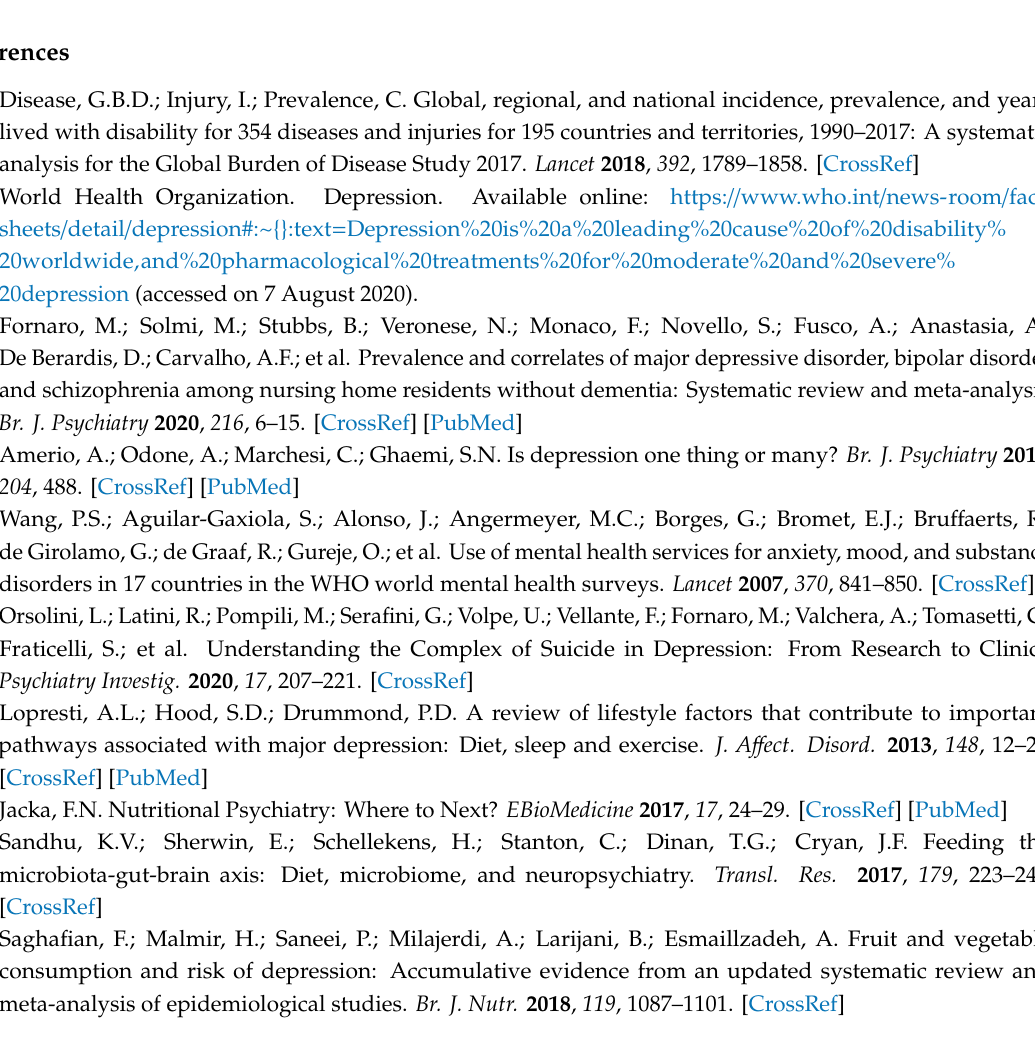
Table S1: Search strategy in PubMed /